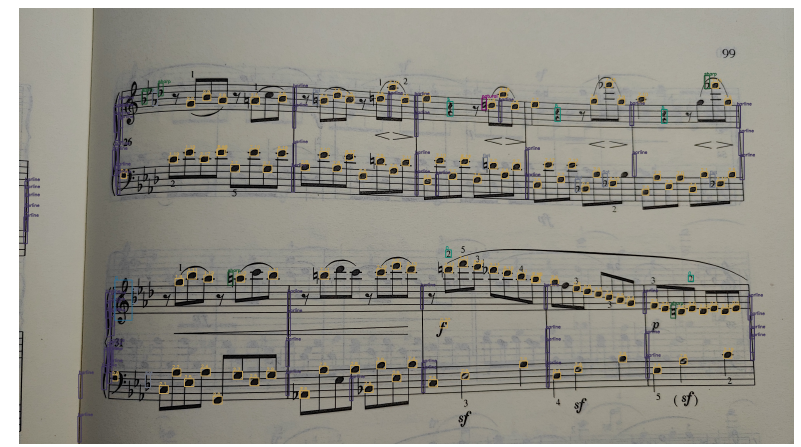
Figure 10. Detection results sample: image taken from a mobile